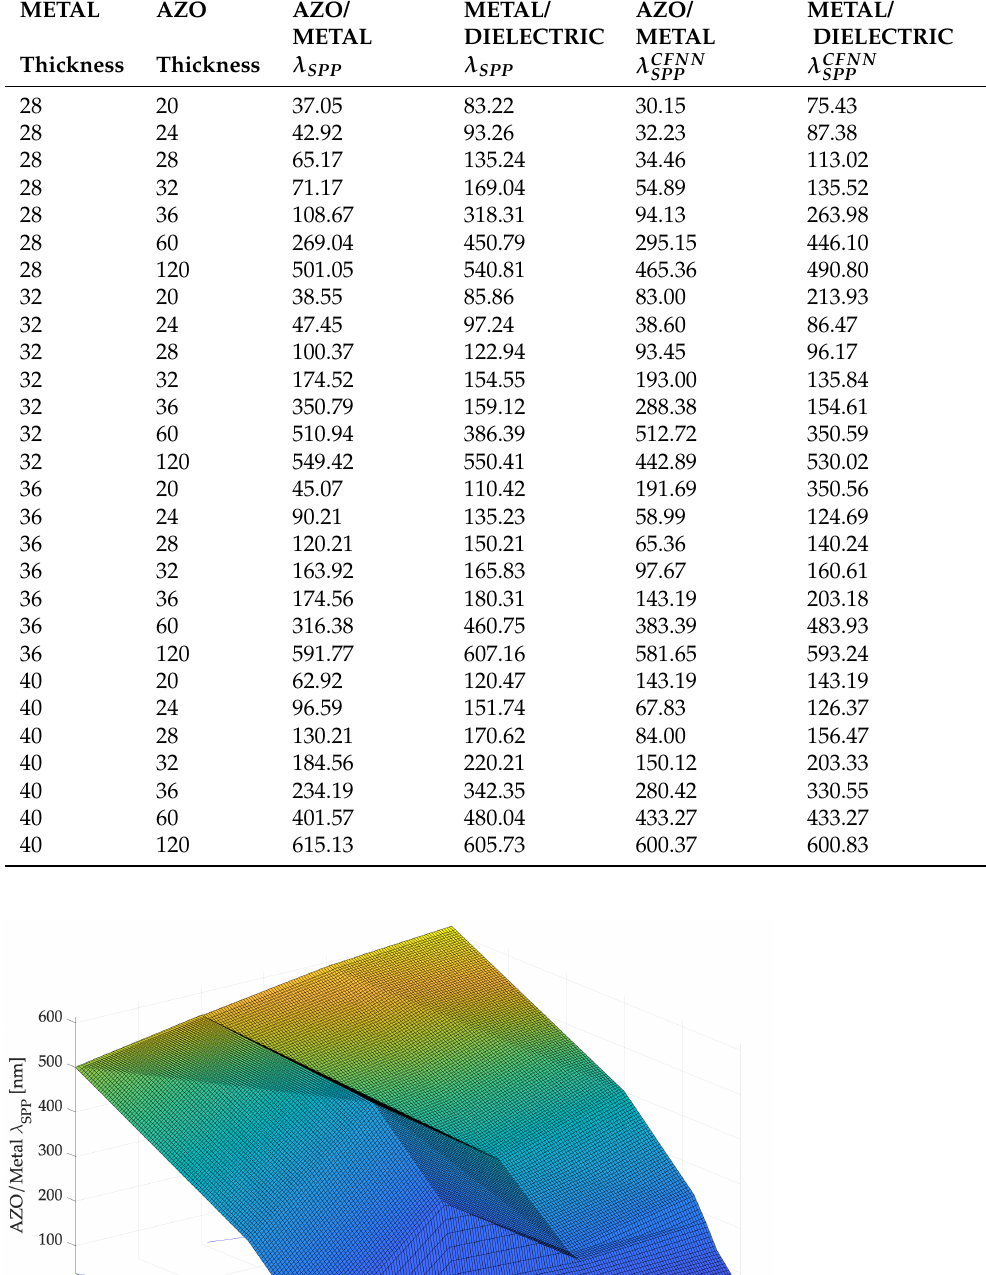
Table 1. Simulation results of the SPP propagation by CFNN: λ SPP − CFNN by changing thickness values (expressed in nm).